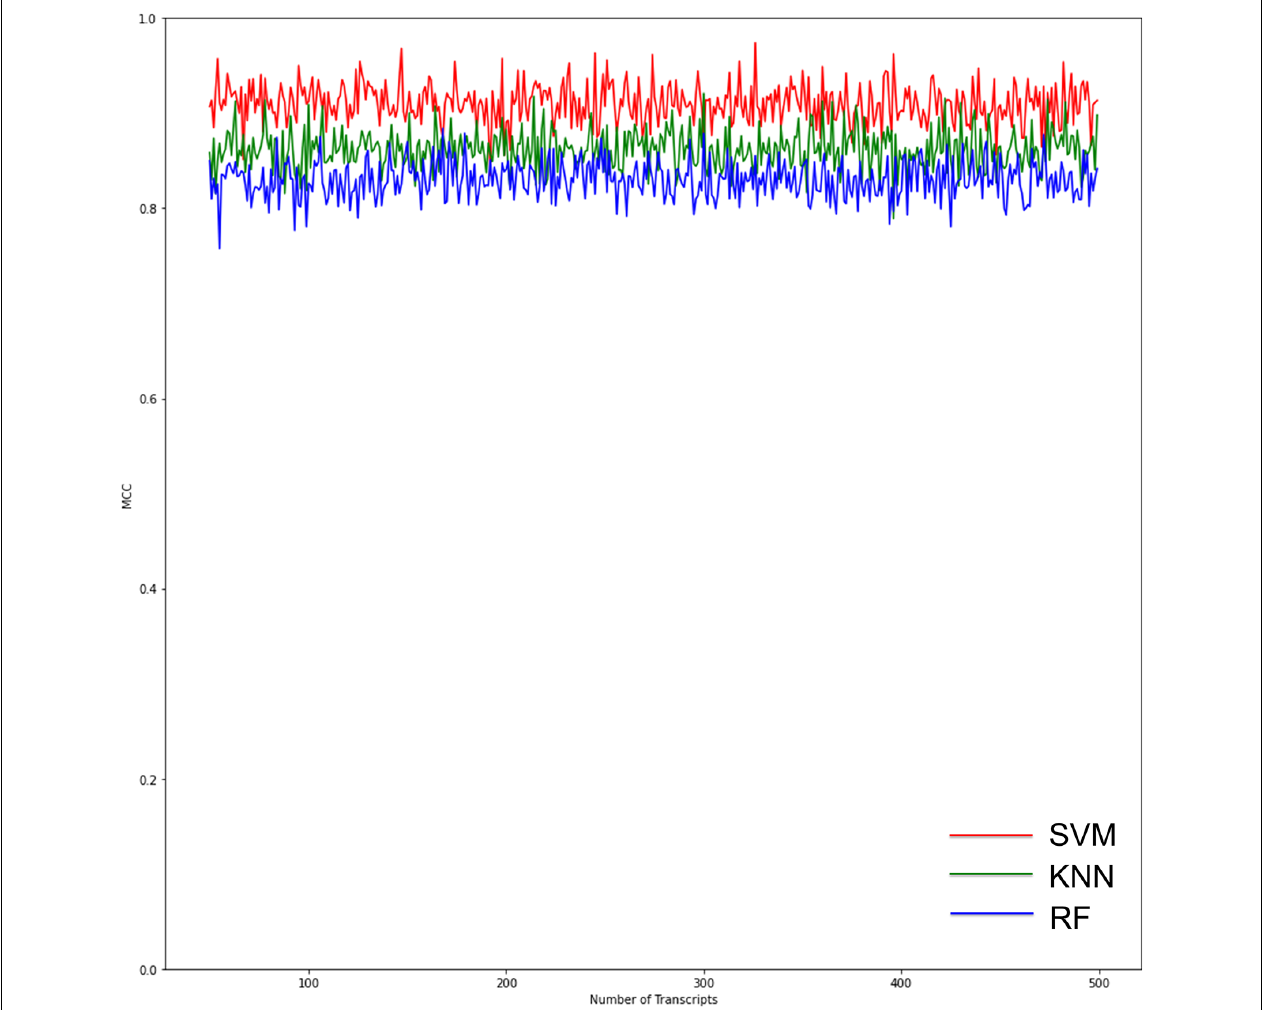
FIGURE 9 | Graphs show the performance of the three ML models according to the number of genes for binary classification. The red curves indicate SVM classifiers. The green curves indicate KNN classifiers. The blue curves indicate RF classifiers. The SVM classifier had the highest Matthews correlation coefficient (MCC) value, which means the highest recognition accuracy and